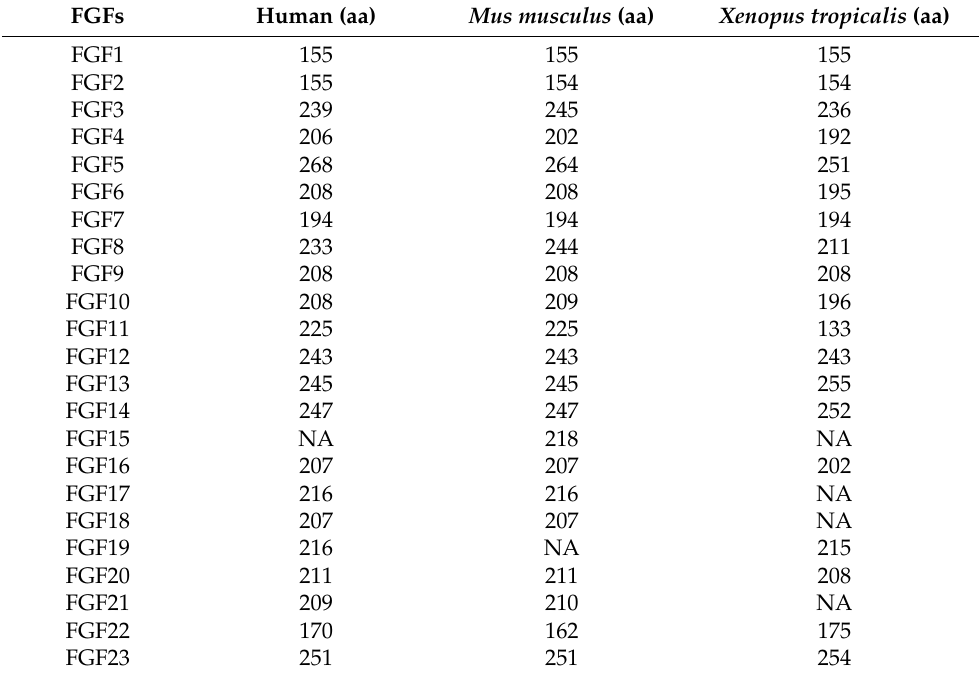
Table 2. Protein length of FGF ligands in different vertebrate species. Information on each protein for human, mouse, and Xenopus models has been sourced from NCBI GeneBank, Uniprot, and Xenbase databases, respectively. FGFs Human (aa) Mus musculus (aa) Xenopus tropicalis (aa) FGF1 155 155 155 FGF2 155 154 154 FGF3